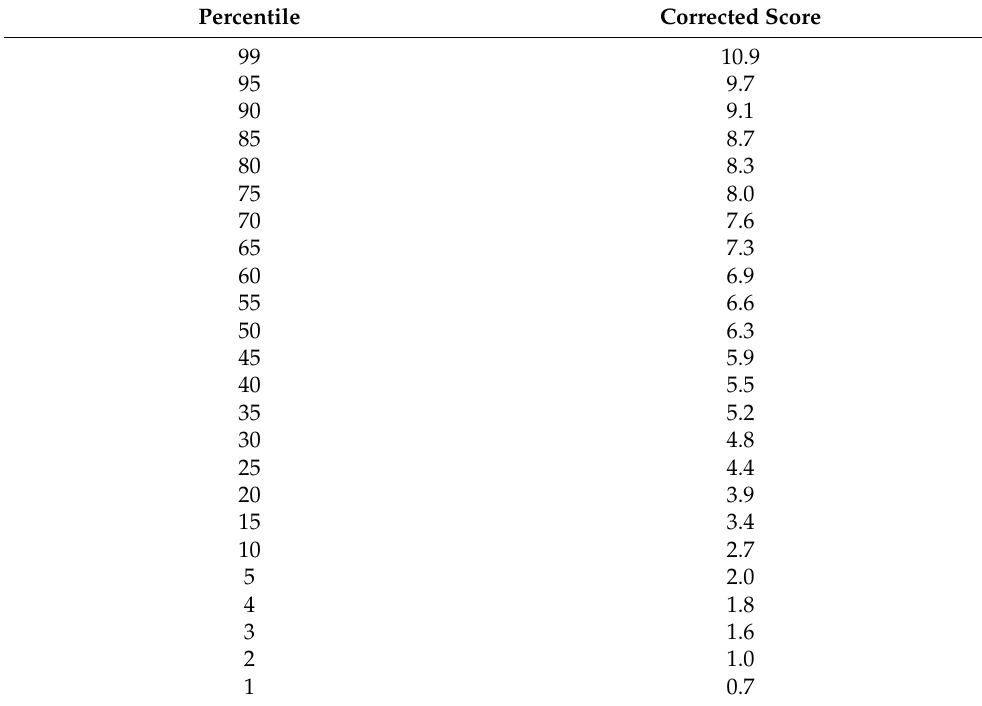
Table 7. Percentiles for corrected scores of GVT accuracy.